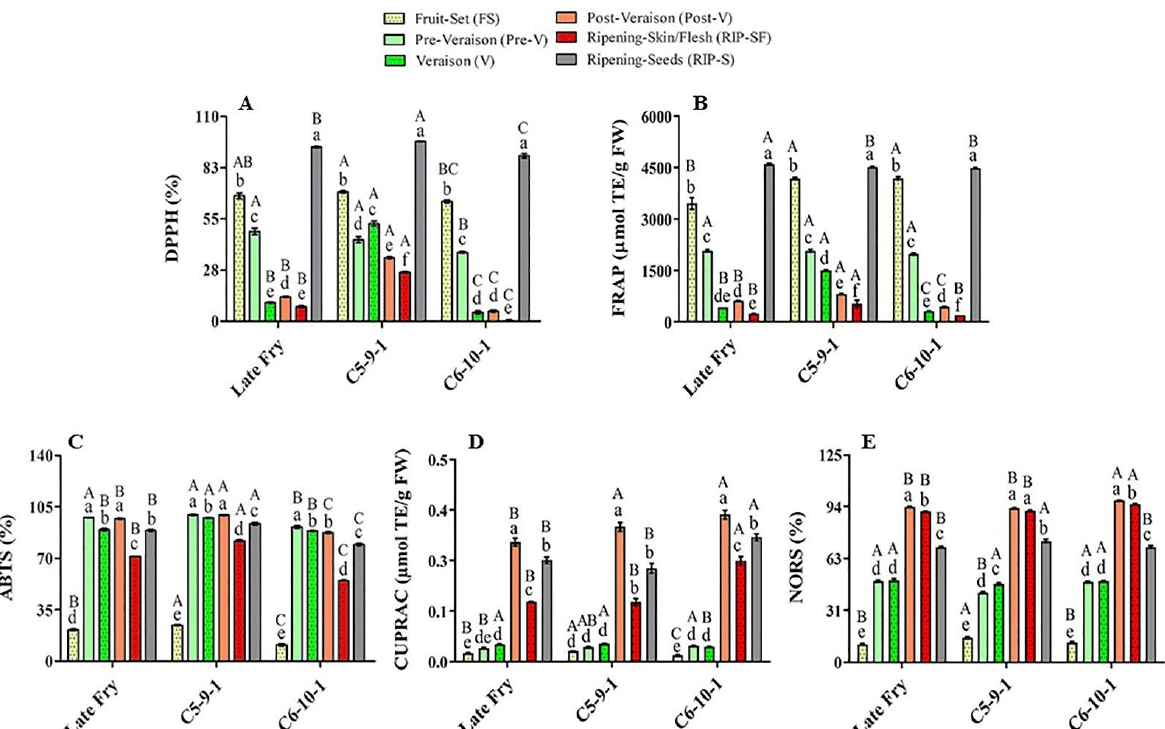
Figure 2. Antioxidant activities of muscadine grape genotypes at different developmental stages were determined using DPPH ( A ), FRAP ( B ), ABTS ( C ), CUPRAC ( D ), and NORS ( E ) assays. The experiments were carried out in three biological replicates, and each replicate was repeated three times ( n = 9). Data represent the mean values ± SD ( n = 3). The different lowercase letters represent the significant differences among developmental stages of an individual genotype, and the different uppercase letters refer to the significant differences between genotypes of a particular developmental stage, according to Duncan’s multiple-range test ( p > 0.05).